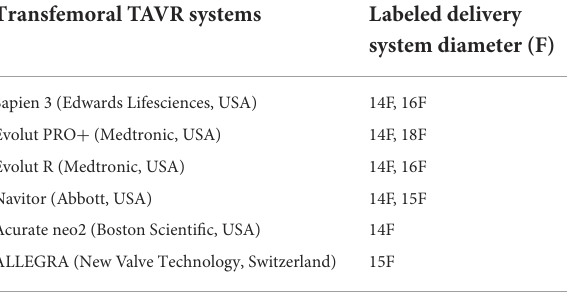
TABLE 1 Caliber of transcatheter aortic valve replacement